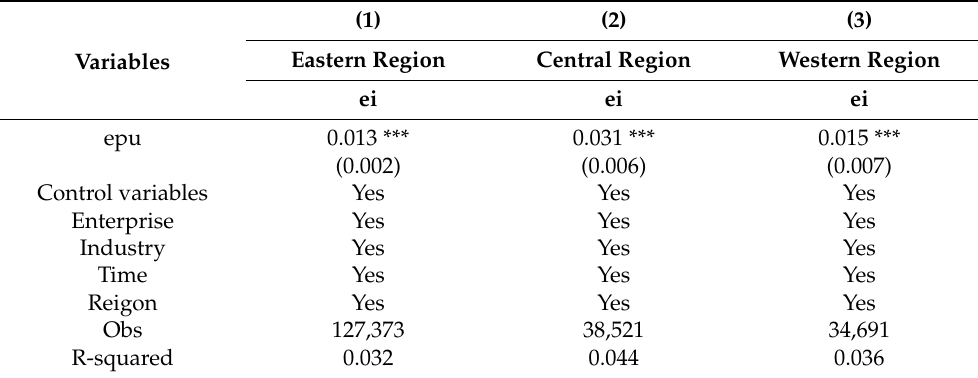
Table 6. Results of enterprise ownership and industry category heterogeneity.